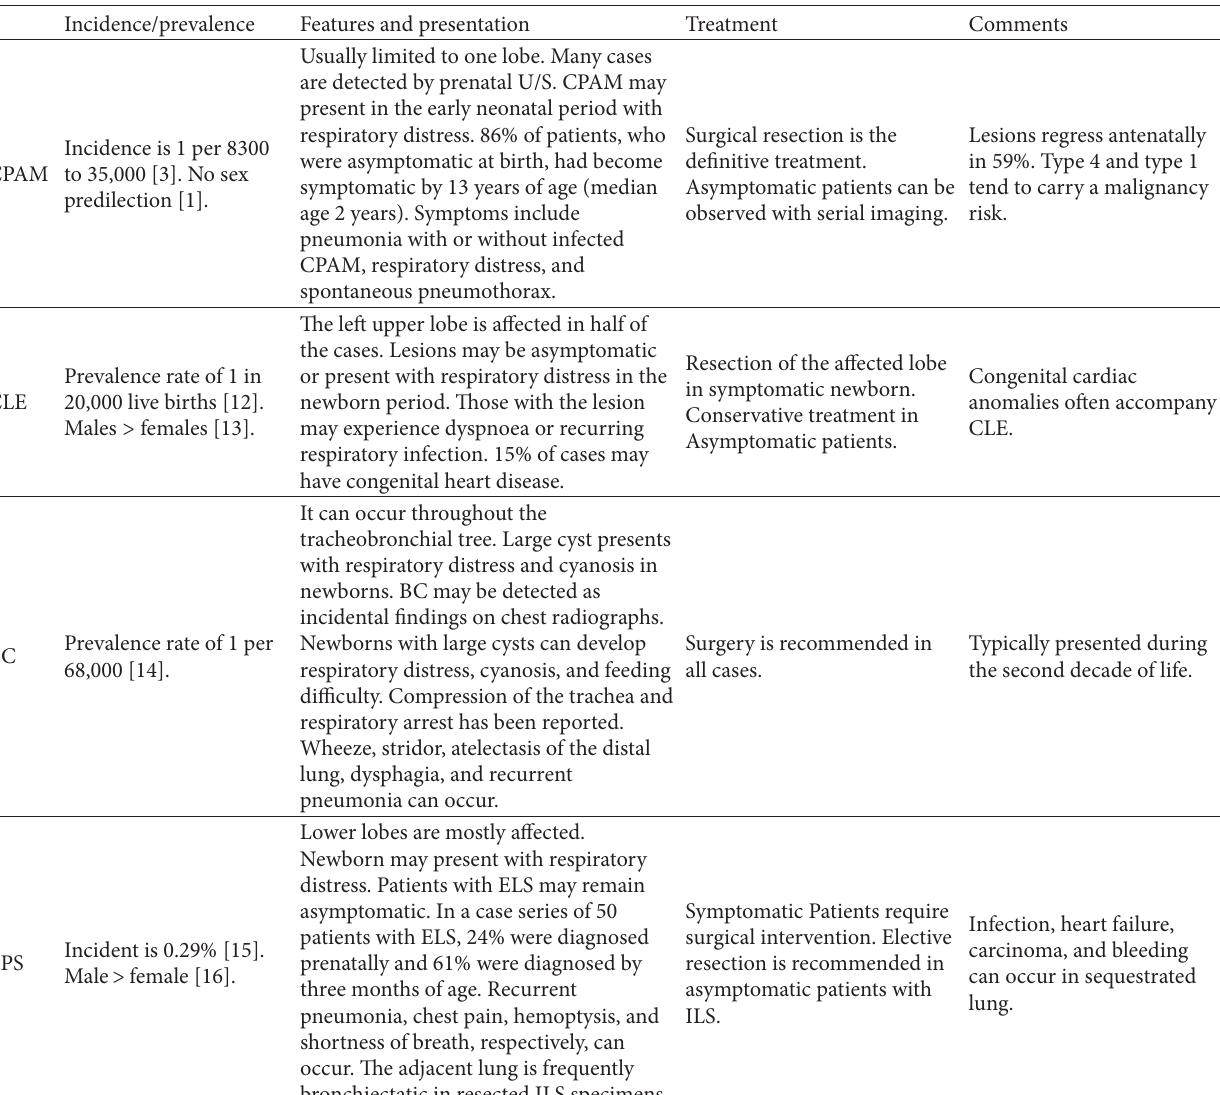
T 1: Common congenital pulmonary